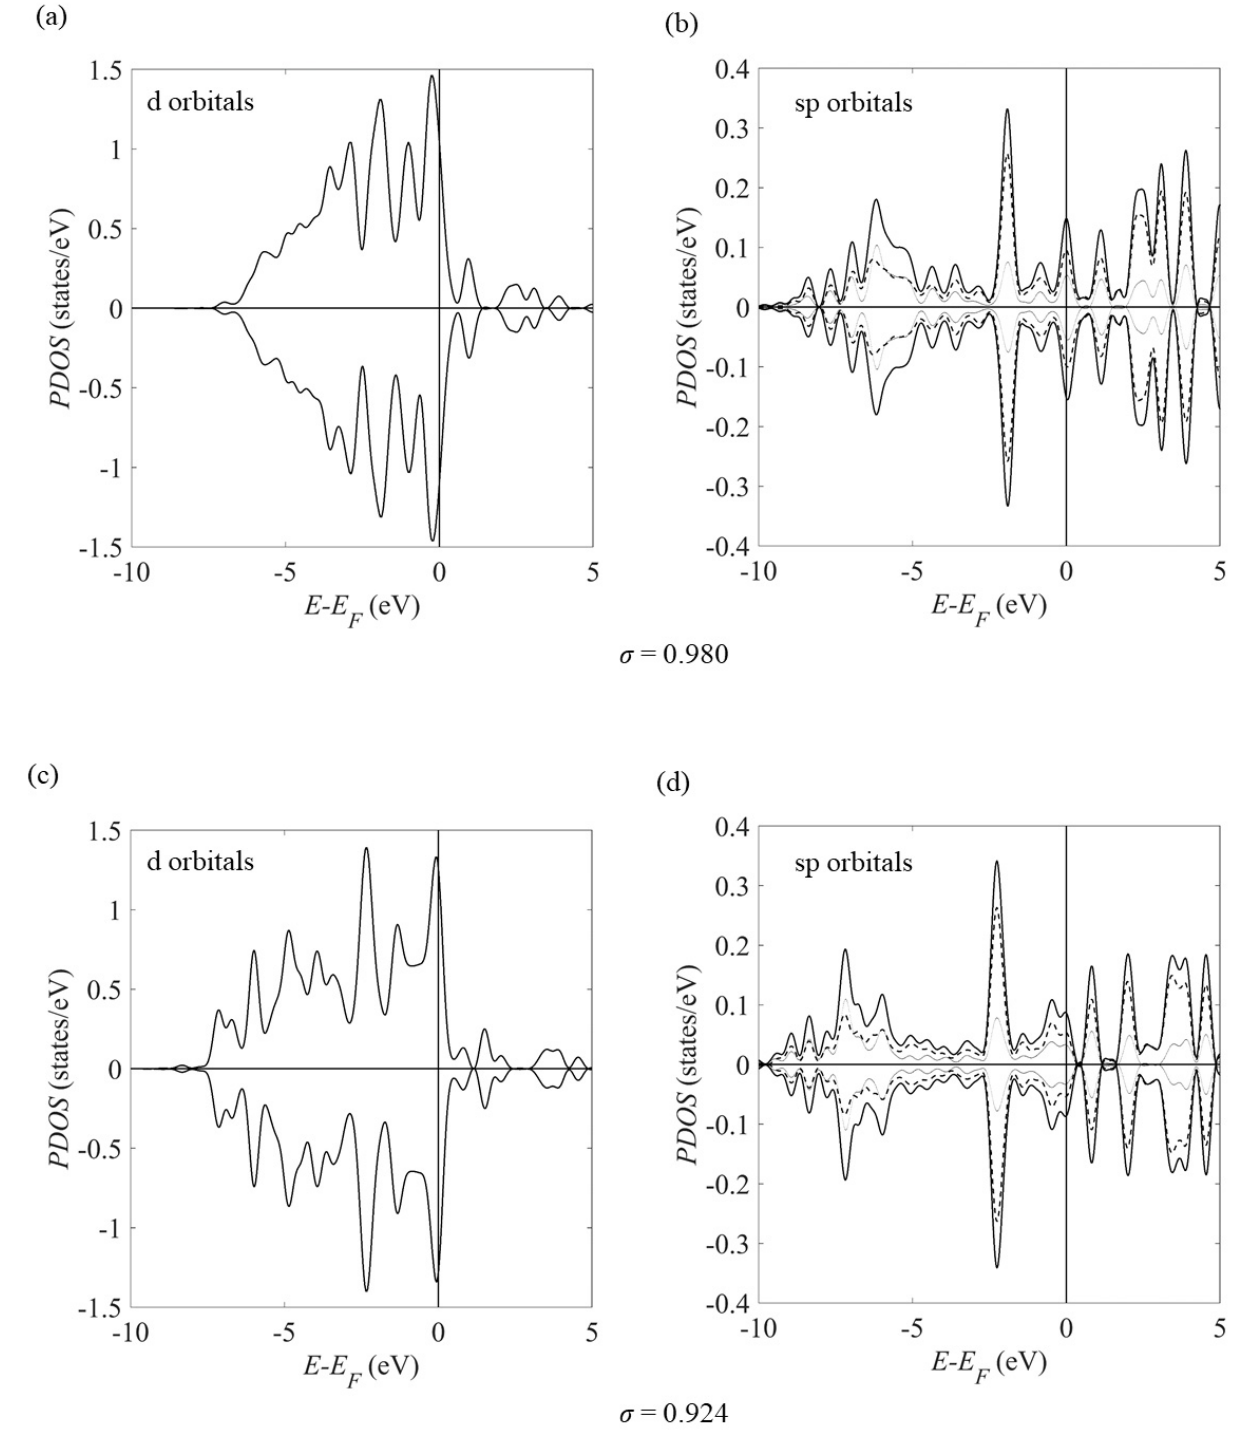
Figure 7. Projected density of states (PDOS) of the surface Pt atoms in a strained Pt(111) slab. The strains σ correspond to the strain in the Pt surface on a ( a , b ) Pt/Ni/Pt 3 Ni and ( c , d ) Pt/Ni/PtNi 3 alloy. The sp orbitals panels ( b , d ) show the s, p and the sum of the s and p PDOS as thin dotted, dashed and thick solid curves, respectively. Each graph shows the spin up and down components as positive and negative curves, respectively.